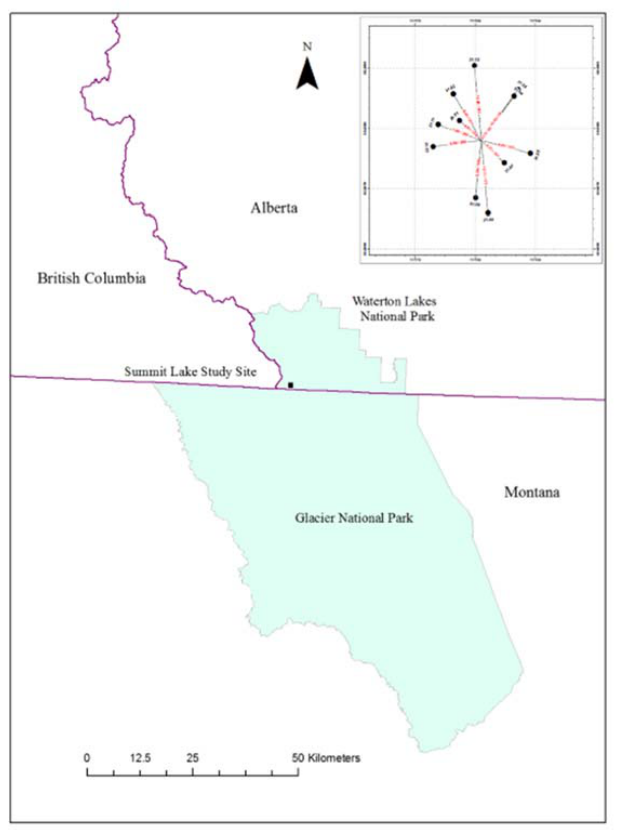
Figure 1. Location of the study site at Summit Lake, Waterton Lakes National Park (49 ′′ 00 ′ 26 ′ N 114 ′′ 01 ′ 31 ′′ W). Inlay is an example of the layout of seedling plantings for one of 21 plots.